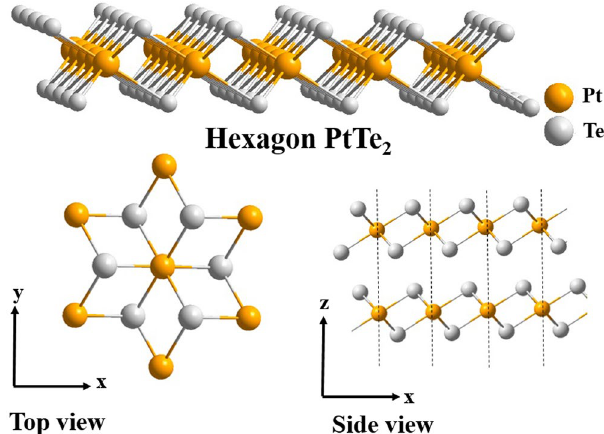
Figure 1. The 3D crystal structure of a monolayer PtTe 2